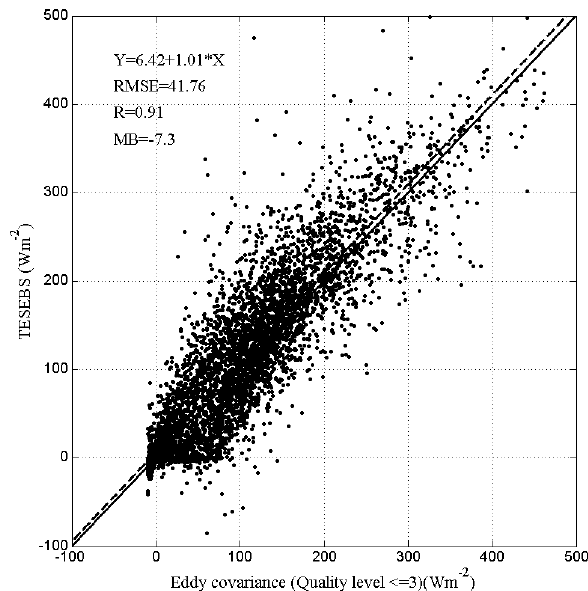
Fig. 2. Evaluation of TESEBS based on the point sensible heat Figure 2. Evaluation of TESEBS based on the point sensible heat flux data of high quality (with 850 quality level <= 3) in 2007 at QOMS/CAS station. Scatter plot of sensible heat flux (H, unit of 851 flux data of high quality (with quality level < =3) in 2007 at Wm -2 ) between the measurements of eddy covariance (ED) and outputs of TESEBS. The thick 852 QOMS/CAS station. Scatter plot of sensible heat flux ( H , unit of line is 1:1 line. The linear fitting line is dashed line. Root Mean Square Error (RMSE). 853 Wm − 2 ) between the measurements of eddy covariance (ED) and Correlation coefficient (R). Mean Bias (MB). 854 855 outputs of TESEBS. The thick line is 1:1 line. The linear fitting line is dashed line. Root mean square error (RMSE). Correlation coefficient ( R ). Mean bias (MB).